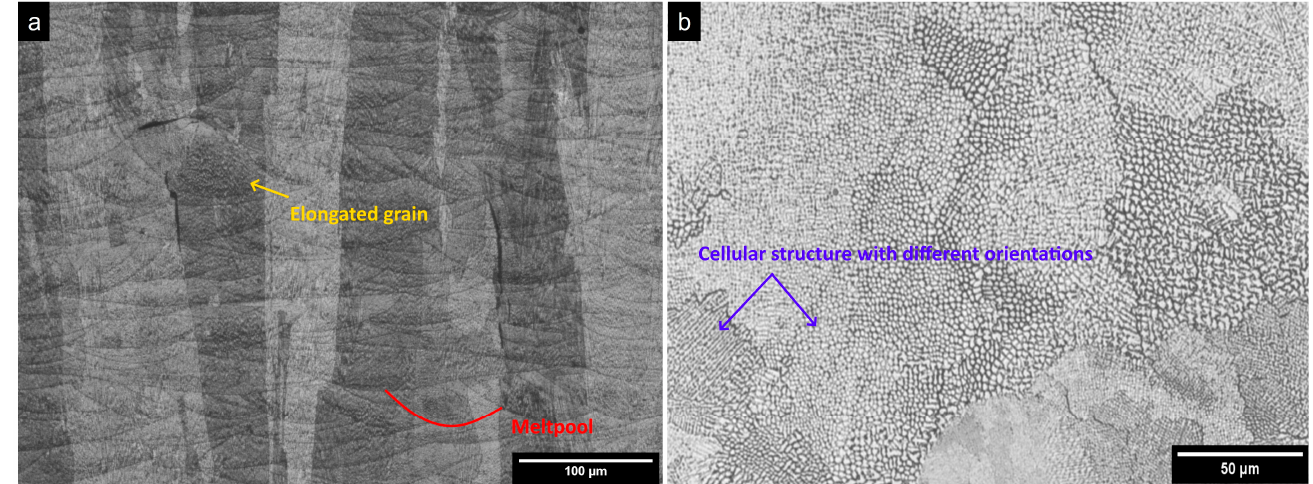
Figure 13. René 80 microstructure at the optical microscope: ( a ) detail of melt pools, grains elongated along the building direction and a crack developing on the grain boundary and ( b ) detail of the cellular structure.